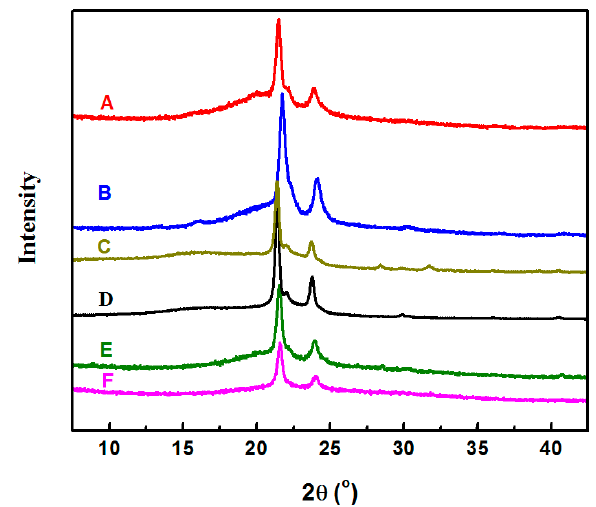
Figure 4. XRD patterns of the electrospun mats of P1 ( A in red) and P2 ( B in blue), P1 annealed ( C in dark yellow) and P2 annealed ( D in black) at 47 °C, casted films of P1 ( E in olive) and P2 ( F in magenta). Crystallinity is determined from ratio of the area under the peaks to the total area under the curve as reported in the literature [27].